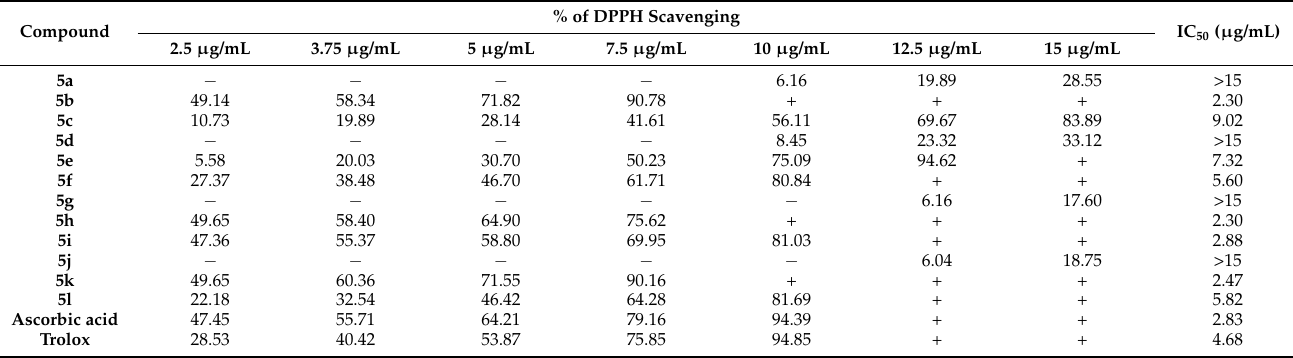
Table 2. Results of the DPPH scavenging assay.